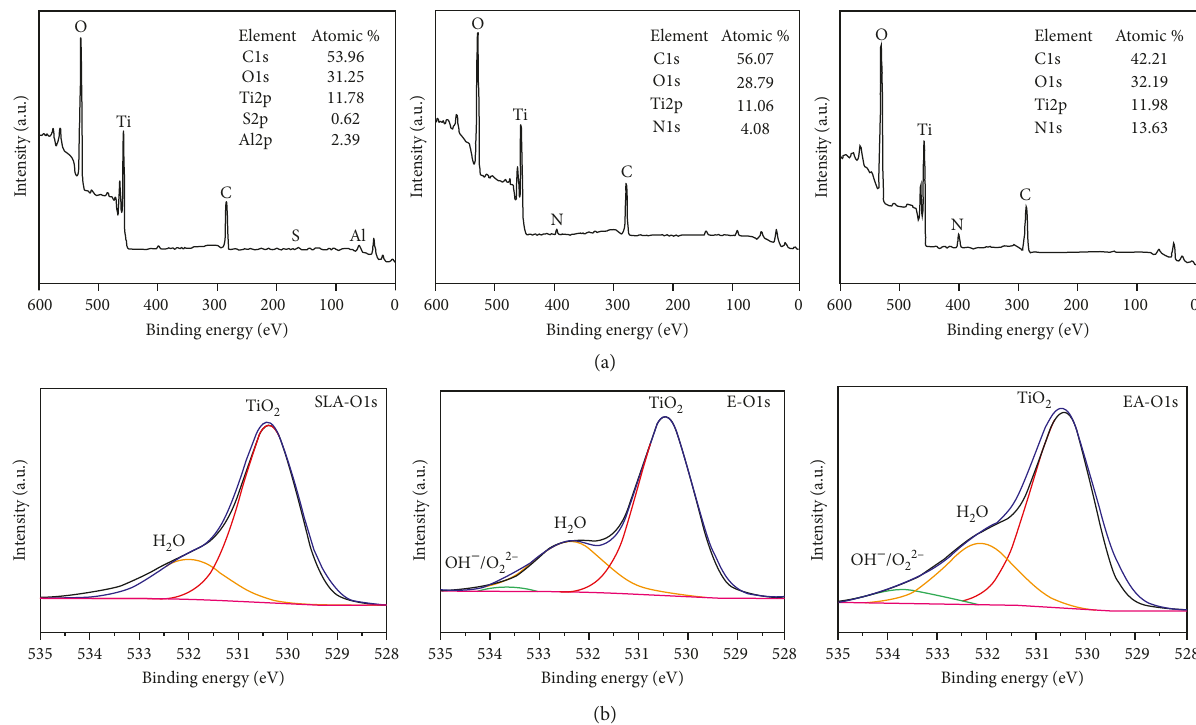
Figure 2: XPS survey spectra of SLA, E, and EA surfaces (a); XPS narrow spectra of O1s on SLA, E, and EA surfaces